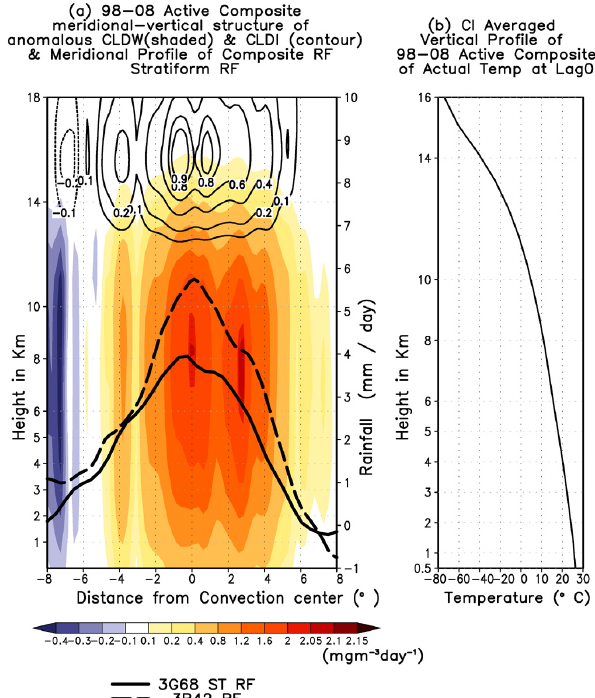
Fig. 15. (a) Domain averaged vertical distribution of cloud wa- ter (mgm − 3 day − 1 ) (shaded), cloud ice (mgm − 3 day − 1 ) (contour) with respect to convection centre superimposed with total rainfall (mmday − 1 ) (solid line) and stratiform rainfall (mmday − 1 ) (bro- ken line), (b) domain averaged vertical profile of temperature ( ◦ C) at lag 0.